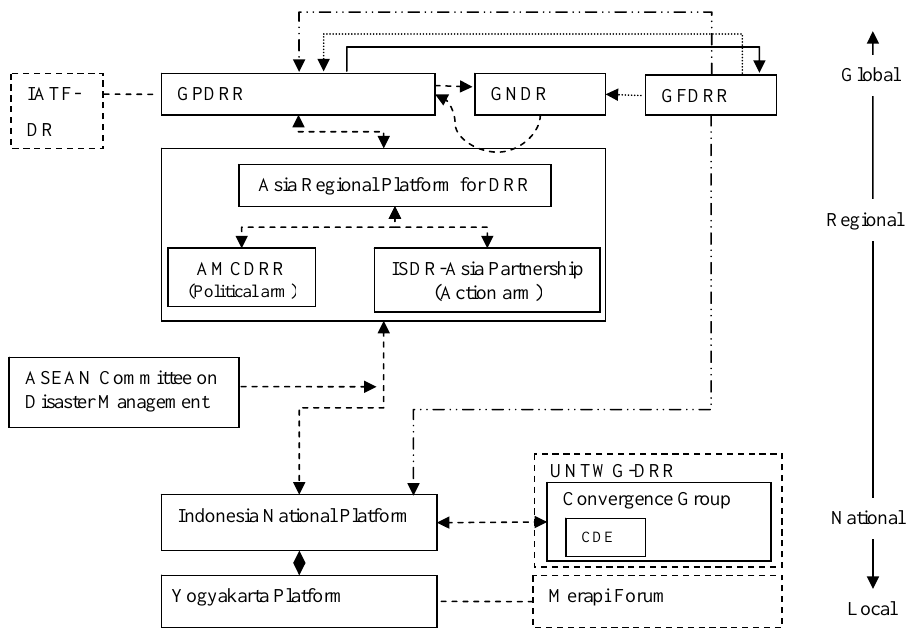
Fig. 3. Relationships between selected MSPs. Figure 3: Relationships between selected MSPs 2 . 457